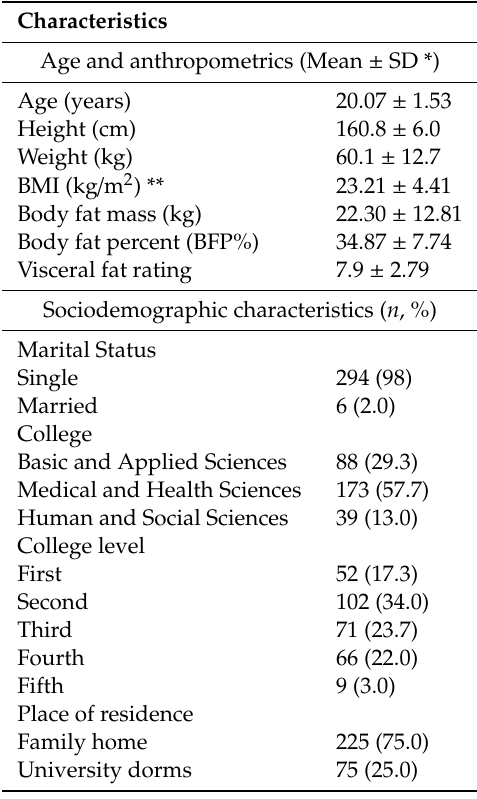
Table 1. Participants’ sociodemographic characteristics and anthropometric measurements ( n =